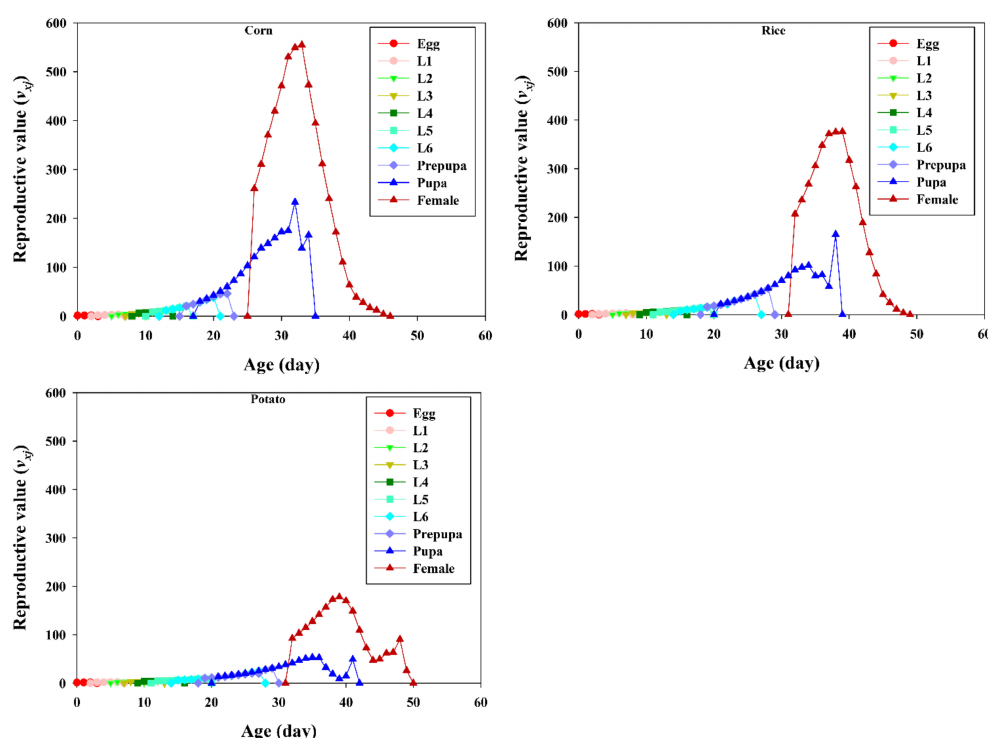
Figure 5. Age-stage-specific reproductive values ( v xj ) of Spodoptera frugiperda fed on corn, potato, and rice. L1–L6 are the larval instars from first to